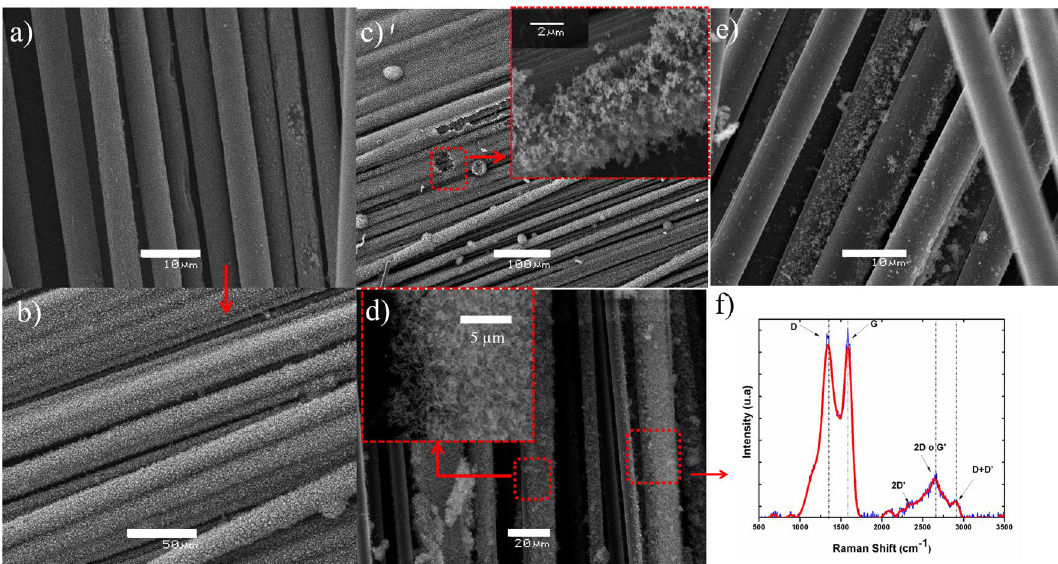
Figure 4. SEM images of CNTs grown via Poptube method on VCFs with polypyrrole/ferrocene ( a , b ). CNTs grown on RCFs to 500 °C with polypyrrole/ferrocene ( c , d ) and ferrocene ( e ). Raman spectrum of RCFs 500 °C with CNTs ( f ).